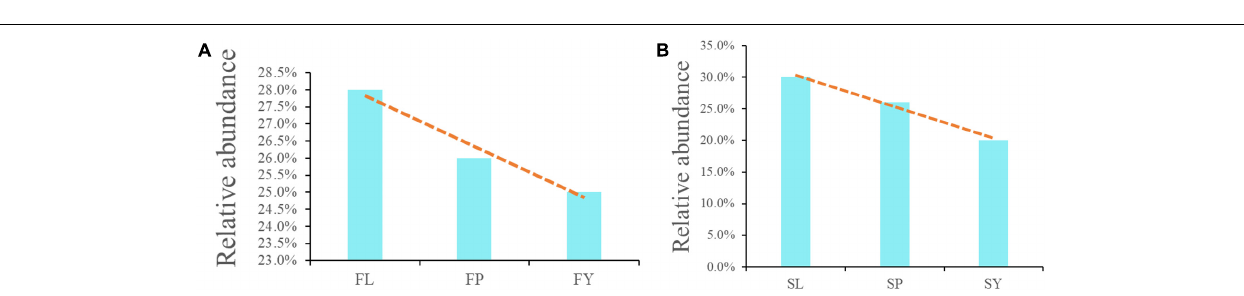
FIGURE 3 | The difference in diversity index of endophytic fungi community in L. chuanxiong in different periods. L refers to Lingzi; P refers to Puxiong; Y refers to Chuanxiong. * is defined as significant, *** is defined as extremely significant.